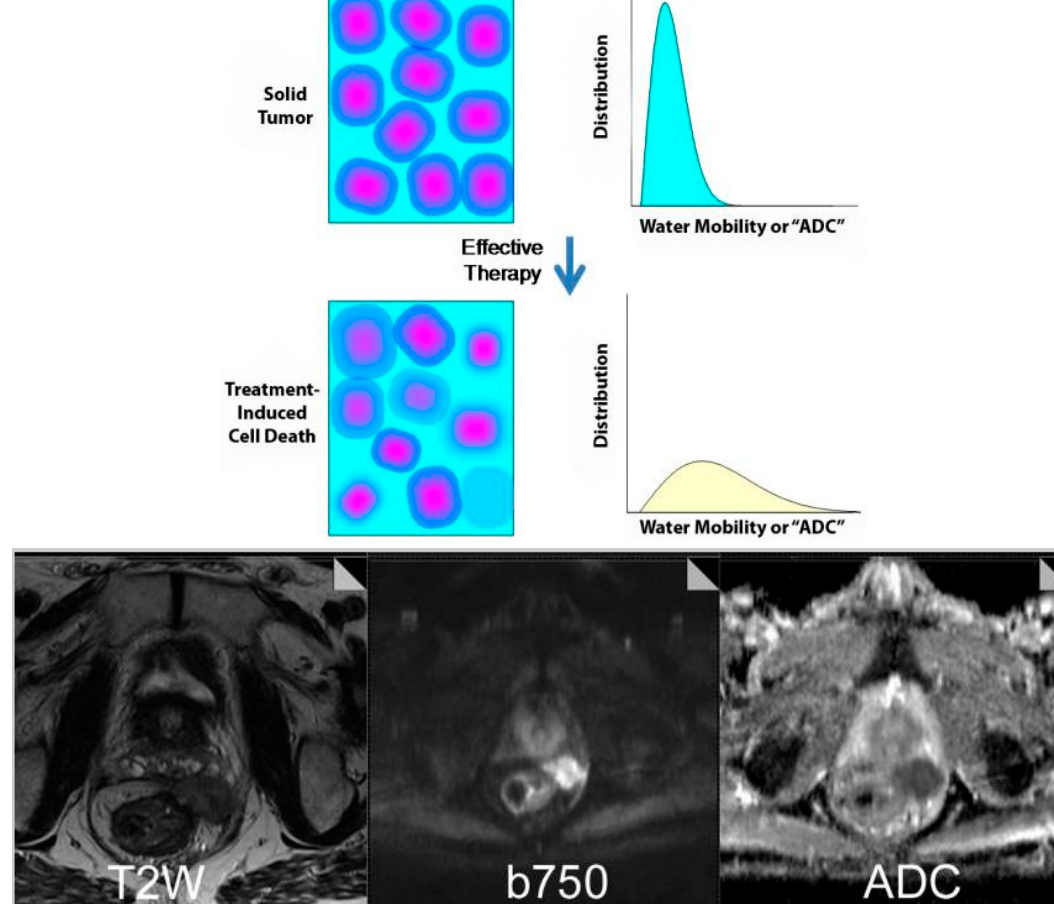
Figure 1. Restricted diffusion within rectal cancer with extension into the perirectal space. T2-weighted image demonstrate a well-circumscribed lesion in the perirectal space. Diffusion-weighted image obtained at a b value of 750 demonstrates a high signal, and corresponding ADC map demonstrates relatively restricted diffusion within the tumour. Figure reproduced with permission from Padhani et al. [24].